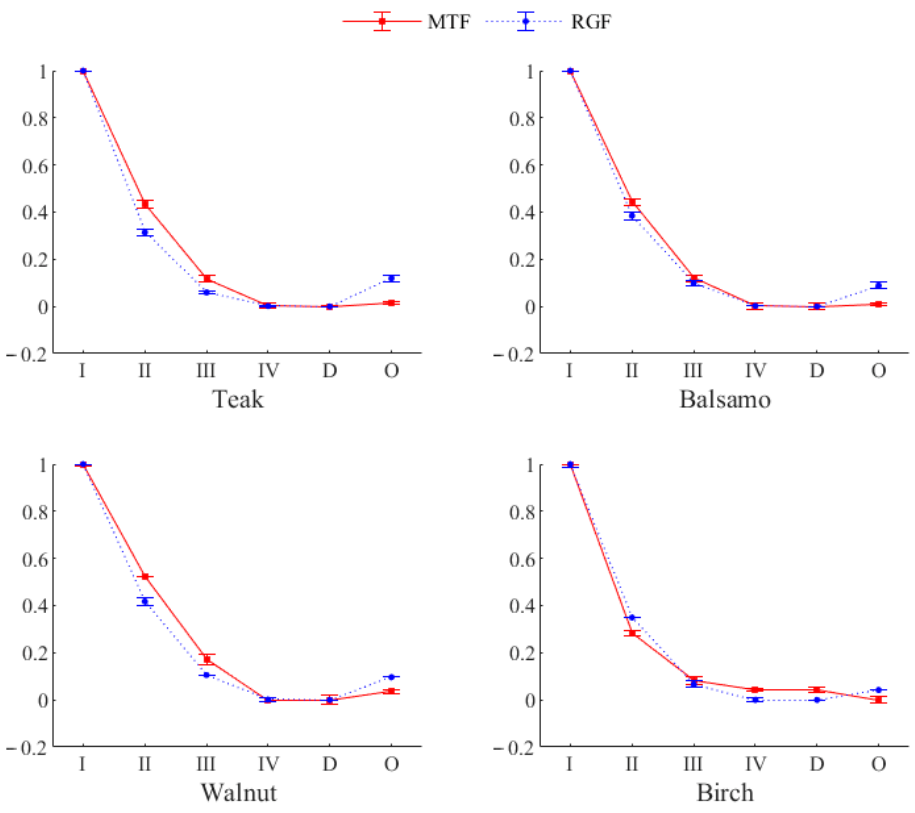
Figure 4. The changing trends of normalized MTF and RGF values under six sharpening schemes. D represents denoised images; O represents original images.